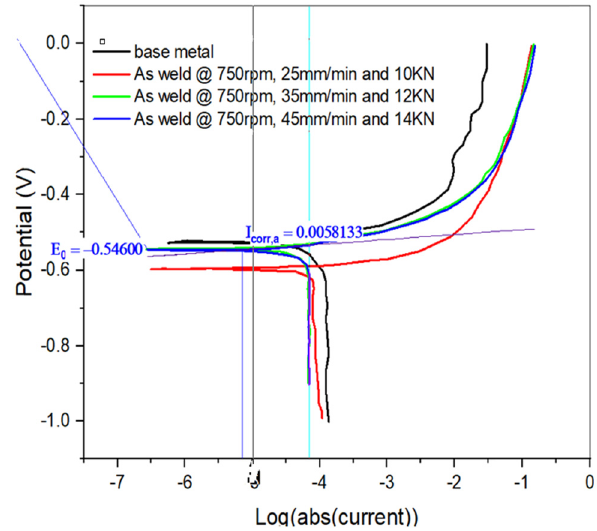
Figure 6: Tafel plots of base metal and FSW 1 and FSW 2